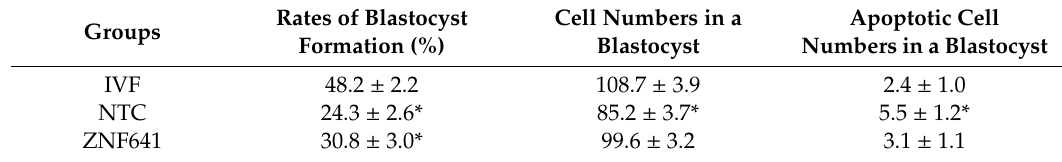
Table 3. Effects of ZNF641 overexpression on the development and quality of cloned embryos. Groups Rates of Blastocyst Formation (%) Cell Numbers in a Apoptotic Cell Blastocyst